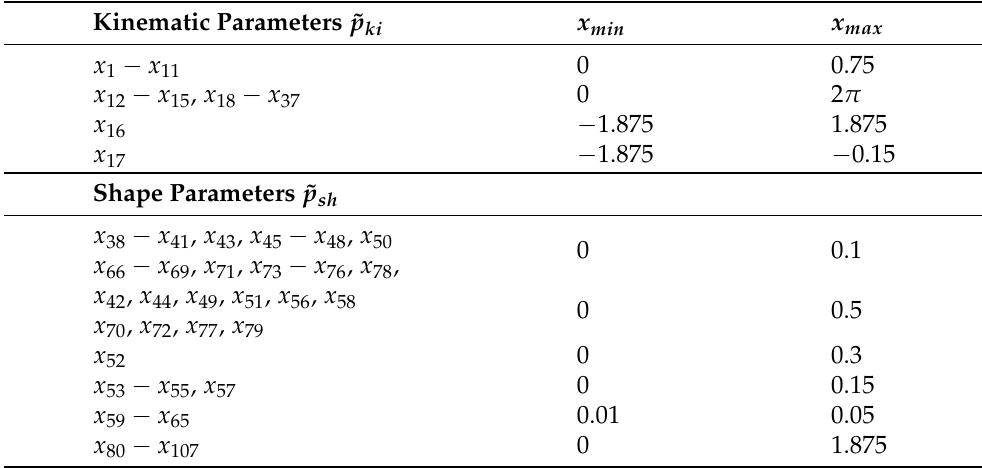
Table 4. The maximum and minimum parameters for the design variable vector x for the eight-bar linkage mechanism.